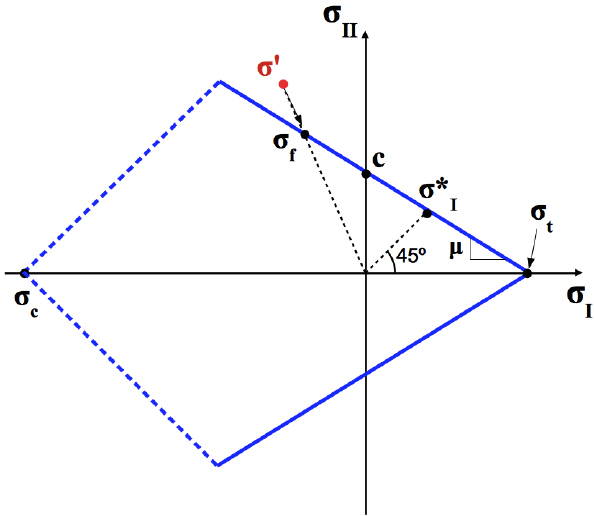
Figure 2. Yield criterion (Mohr–Coulomb and compressive cut- off) in stress invariant space ( σ I , σ II ) with following the mechan- ical strength parameters: compressive strength ( σ c ), cohesion ( c ), coefficient of internal friction ( µ = sin φ , φ being the angle of in- ternal friction), isotropic tensile strength ( σ t ) and uniaxial tensile strength ( σ ∗ , where the second principal stress invariant σ 2 is zero I or σ I = σ II = σ ∗ ). The stress before and after the correction (see I Eq. 13) is denoted by σ (cid:48) , and σ f , respectively. The correction from σ (cid:48) to σ f is done following a line going through the